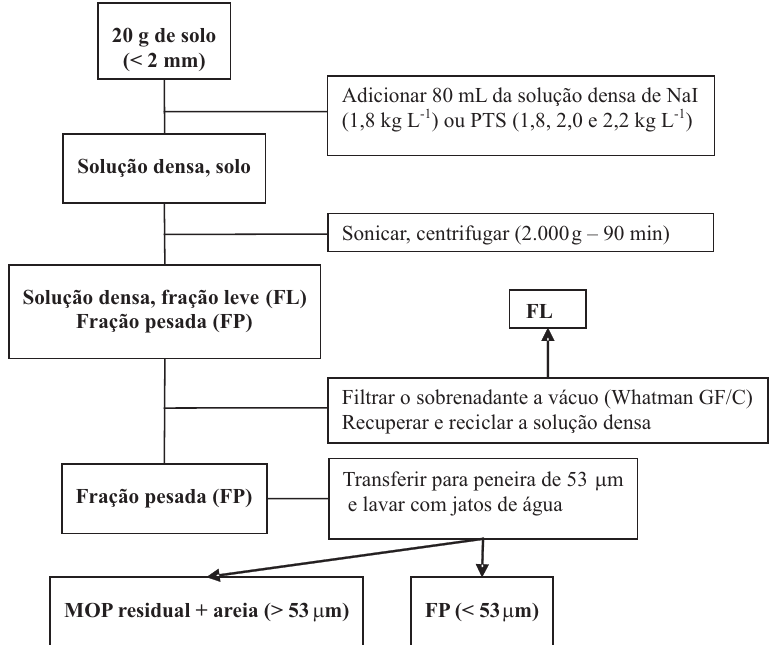
Figura 1. Organograma do fracionamento físico densimétrico. MOP: matéria orgânica